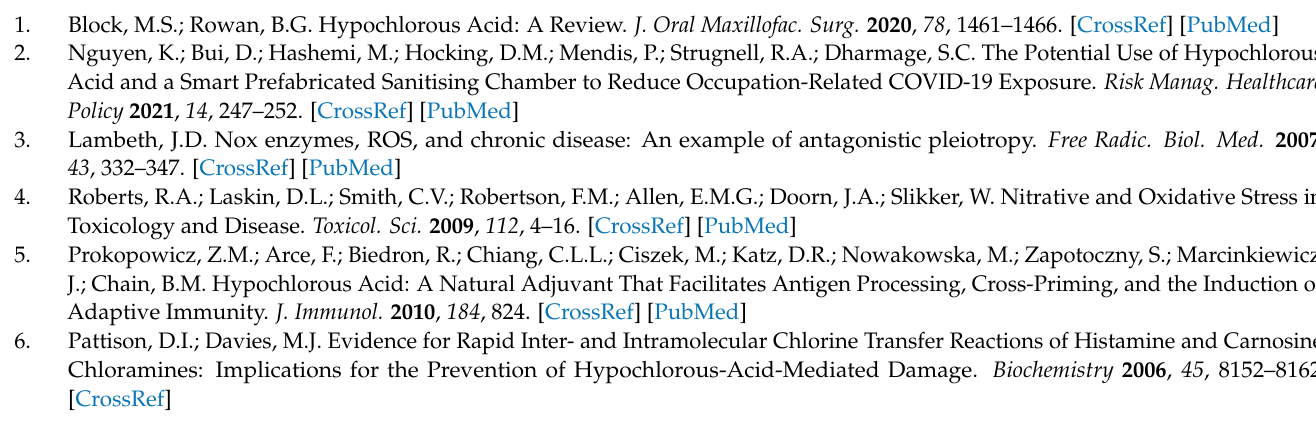
C NMR spectrum of 3 ; Figure S3: 1 H NMR spectrum of 4 ; Figure S4: 13 C NMR spectrum of 4 ; Figure S5: 1 H NMR spectrum of 5 ; Figure S6: 13 C NMR spectrum of 5 ; Figure S7: Mass spectrum of 3 ; Figure S8: Mass spectrum of 4 ; Figure S9: Mass sprctrum of 5 ; Figure S10: Emission intensity of 2 in acetonitrile (ACN), ethanol (EtOH), and methanol (MeOH) before and after adding HOCl; Figure S11: Emission intensity of 2 before and after adding HOCl in MeOH-DI water mixture with various percentages of DI water; Figure S12: FTIR spectra of compound 2 and its HOCl-mediated cyclization product (compound 4 ); Figure S13: Cytotoxicity of compounds 2 and 3 were determined using RAW264.7 cells by MTT assay. Statistical analysis is based on T-test (* p < 0.05, ** p < 0.01, *** p <0.001); Figure S14: Time courses of HOCl-mediated triazolopyridine cyclization reaction of 2 (A) and 3 (B) (0.2 µ M) after addition of HOCl (40 mM) in MeOH-5 mM PBS (1:1 v/v); Figure S15: A) Bar charts demonstrating fluorescence intensities at 512 nm of the sensor (compound 2 ) in the presence of GSH (1–10 mM) B) Bar charts demonstrating fluorescence intensities at 512 nm of the sensor (compounds 2 ) in the presence of HOCl and GSH (1–10 mM); Figure S16: A) Bar charts demonstrating fluorescence intensities at 512 nm of the sensor (compound 3 ) in the presence of GSH (1–10 mM) B) Bar charts demonstrating fluorescence intensities at 512 nm of the sensor (compounds 3 ) in the presence of HOCl and GSH (1–10 mM); Figure S17: Pearson correlation coefficient values for colocalization of compound 2 or compound 3 and Hoechst 33342 obtained from ImageJ; Table S1: Crystal data and structure refinement details for compound 4 ; Table S2: Comparison of BODIPY- based sensors (compounds 2 and 3) developed in this work with the recently reported rhodol-based fluorescence sensors for HOCl determination via triazolopyridine